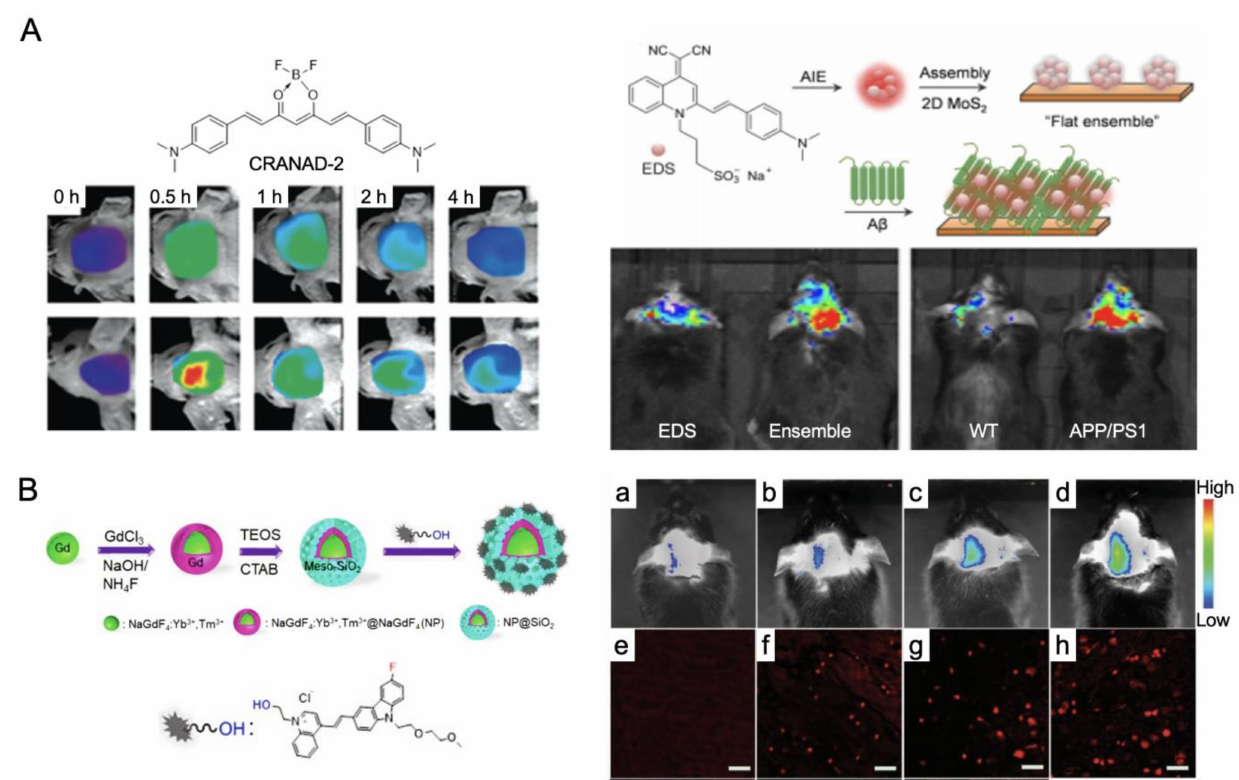
Figure 8. NIR fluorescence imaging for AD diagnosis. ( A ) CRANAD-2 and EDS with MoS 2 fluo- rophores for the detection of A β fibrils in AD mice. Adapted from [128,130] with permission from Elsevier and John Wiley and Sons. ( B ) Gd-based NIR fluorescent NP@SiO2@F-SLOH for in vivo ( a – d ) and ex vivo ( e – h ) fluorescence imaging in AD mice: ( a , e ) from the wild type mice, ( b , f ) 7-month-old Tg mice, ( c , g ) 9-month-old Tg mice, and ( d , h ) 11-month-old Tg mice. Adapted from [131] with permission from John Wiley and